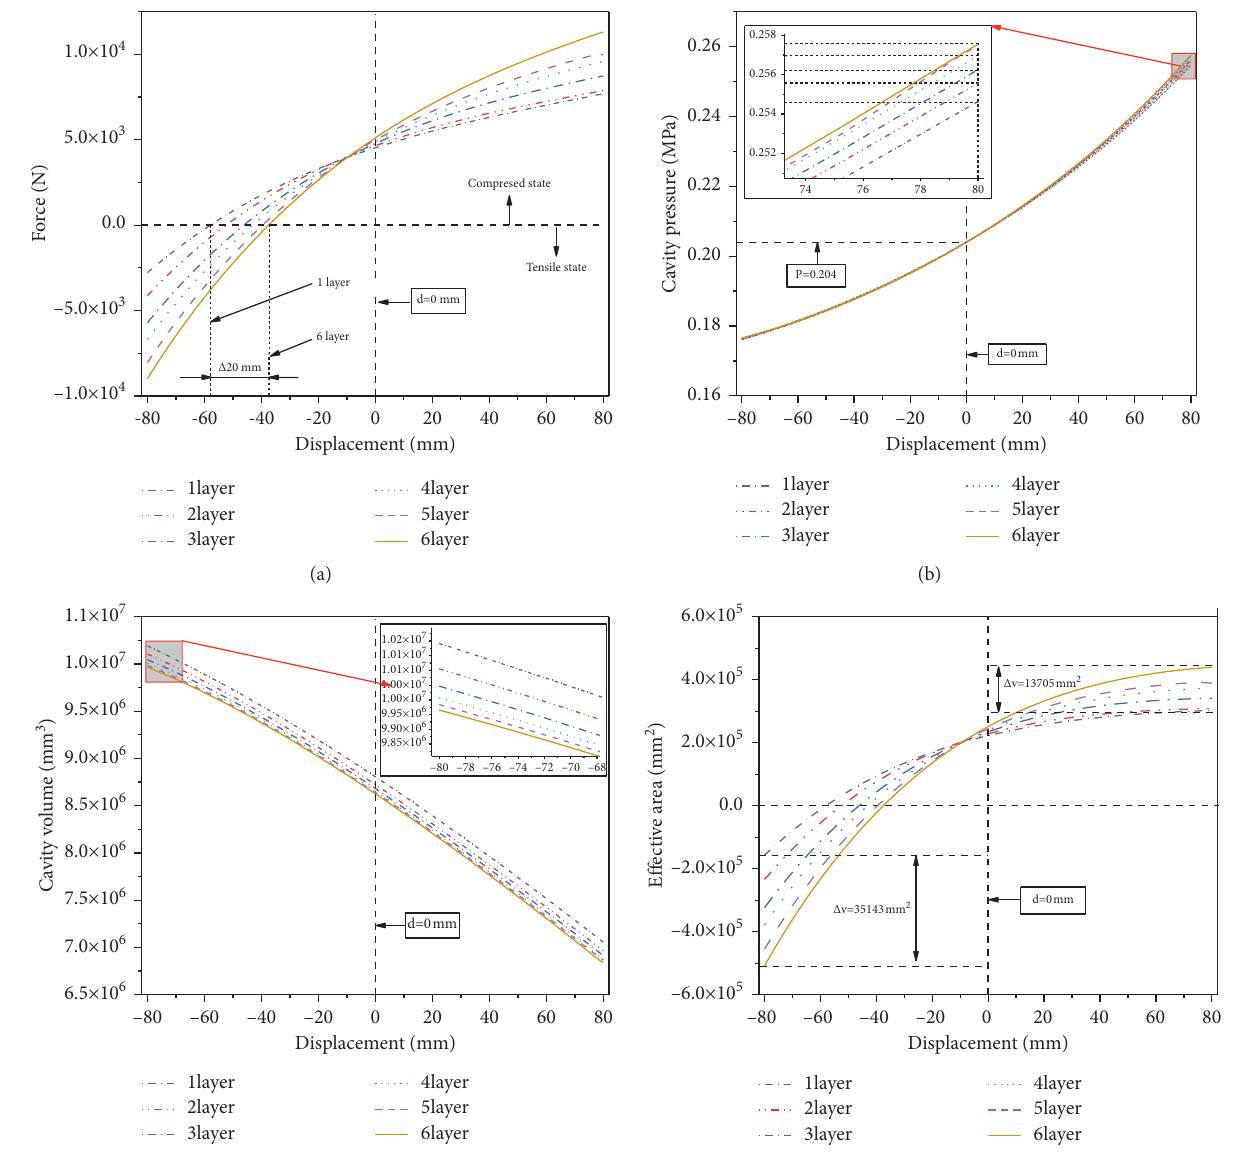
Figure 10: The results of the investigation of the influence of the cord layer on the airbag: (a) for the load, (b) for the pressure, (c) for the volume, and (d) for the effective